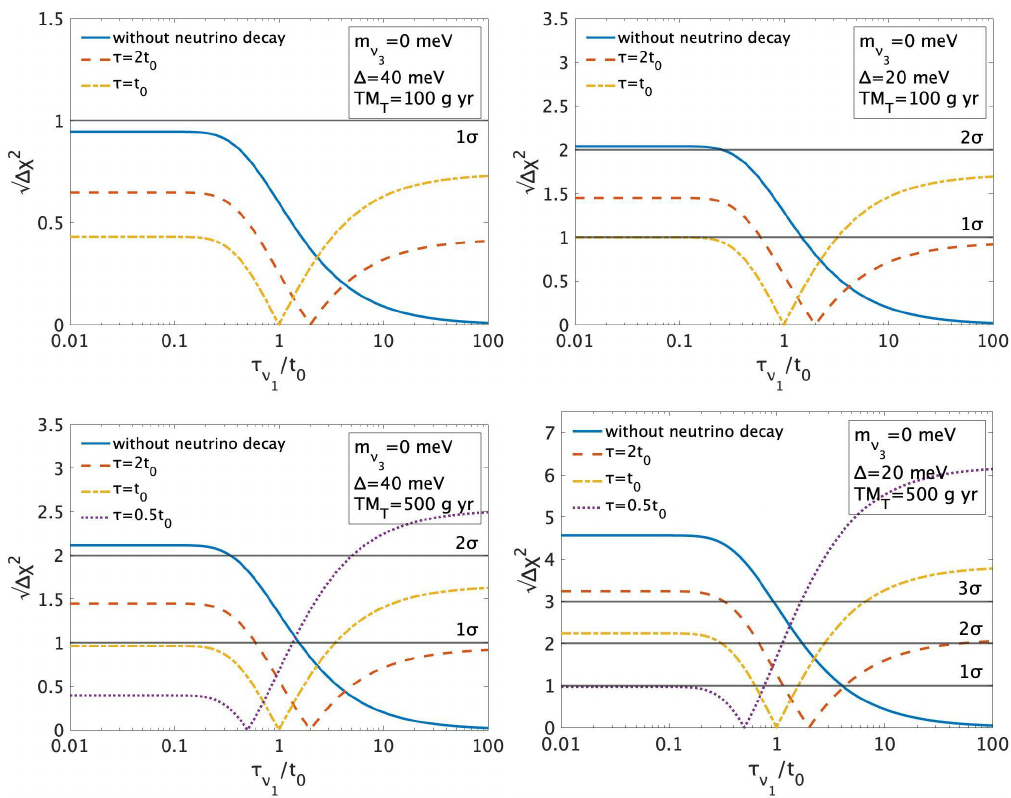
p ∆ for ν in the IO case with m = Figure 8 . χ 2 as a function of a test value of τ ν 1 → ν 4 φ ν 3 1 0 meV , where fiducial values of τ are assumed to be ∞ (blue solid), 2 t (red dashed), t (yellow ν 1 0 0 dash-dotted), 0 . 5 t (purple dotted). We set (TM ∆) = (100 g yr , 40 meV) (top left panel), 0 T , (100 g yr , 20 meV) (top right panel), (500 g yr , 40 meV) (bottom left panel) and (500 g yr , 20 meV) (bottom right panel). In an exposure of 100 g yr, the signal of C ν B with τ . 0 . 5 t cannot be ν 1 0 observed since the number of this event is smaller than one